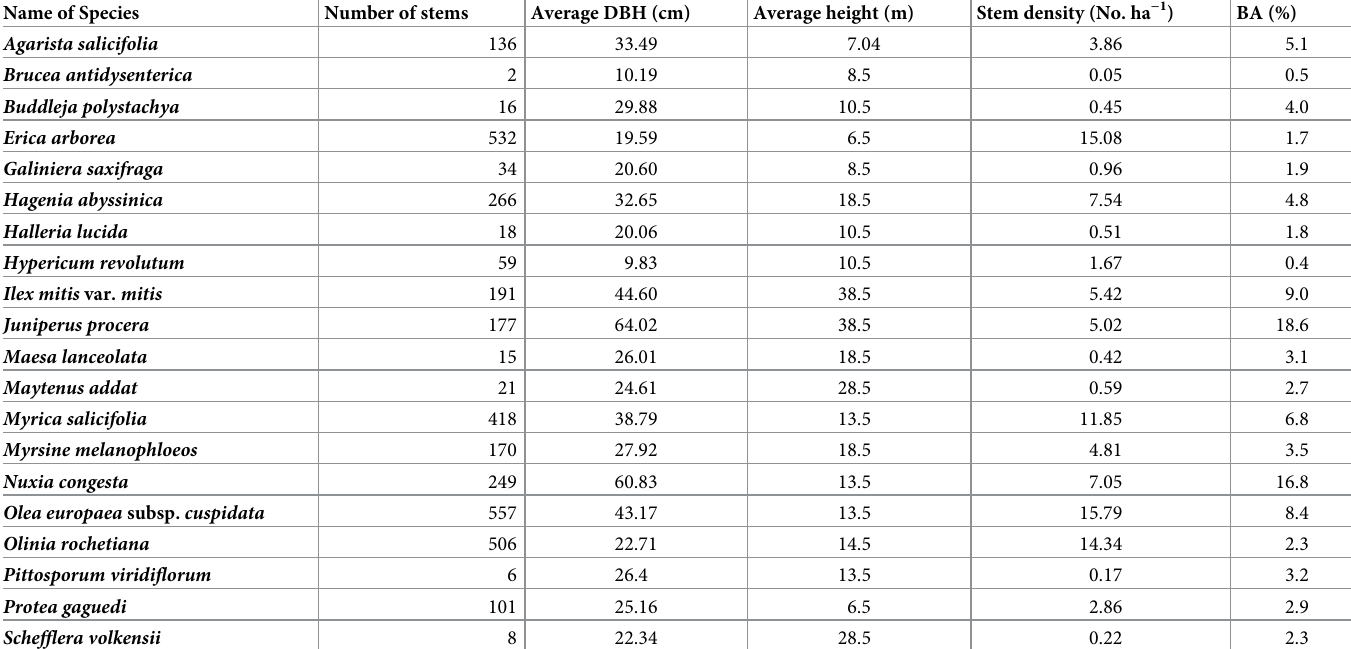
Table 1. Summary of stem density, basal area, average diameter at breast height, and height of 20 tree species in Kibate Forest.